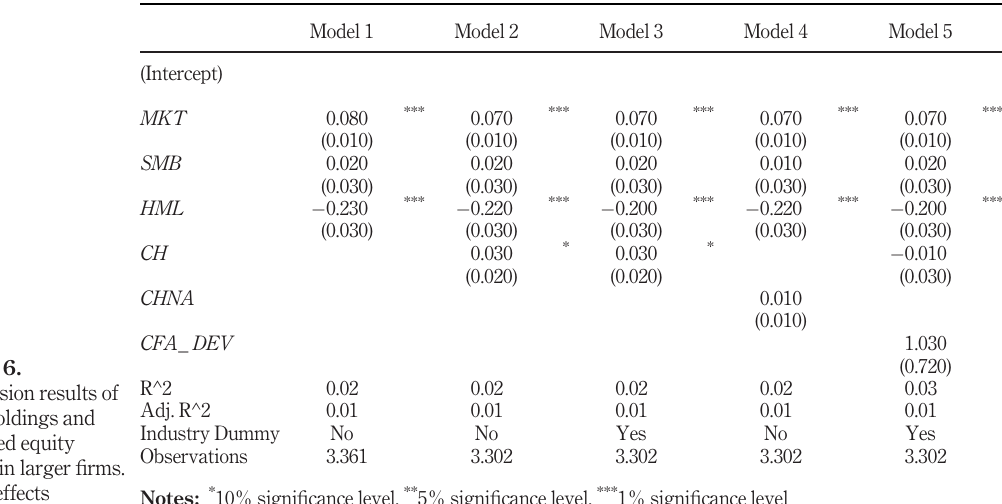
Table 6. Regression results of cash holdings and expected equity return in larger fi